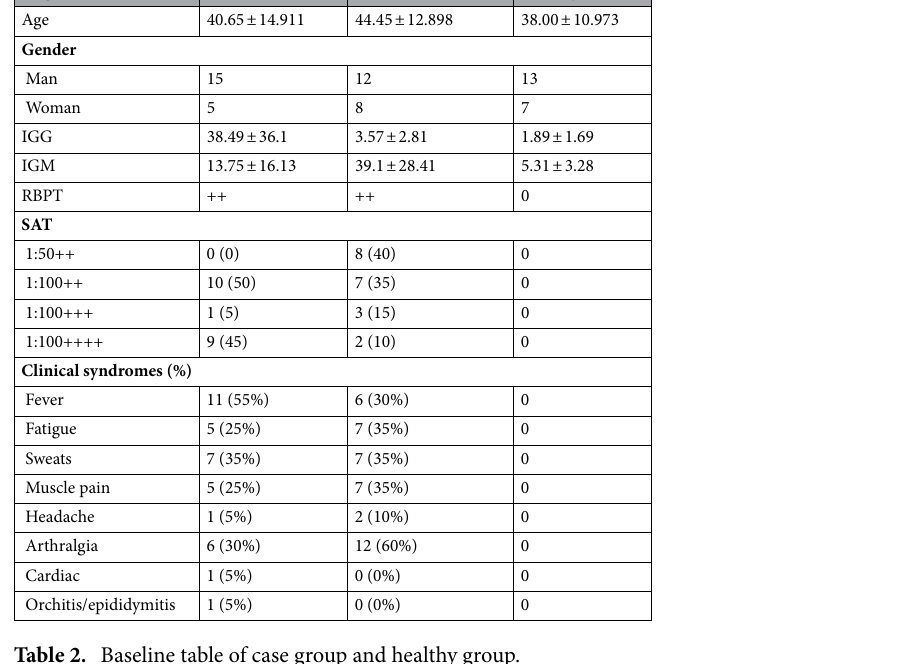
Table 2. Baseline table of case group and healthy